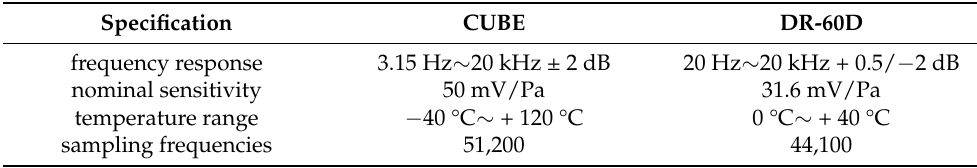
Figure 5. The spectrogram of ( a ) normal (CUBE, Dawu); ( b ) Defect 1 (DR-60D, Dawu); ( c ) Defect 2 (DR-60D, Dawu); and ( d ) Defect 3 (CUBE, Diaoyutai). Table 2. Technical specifications of the acquisition